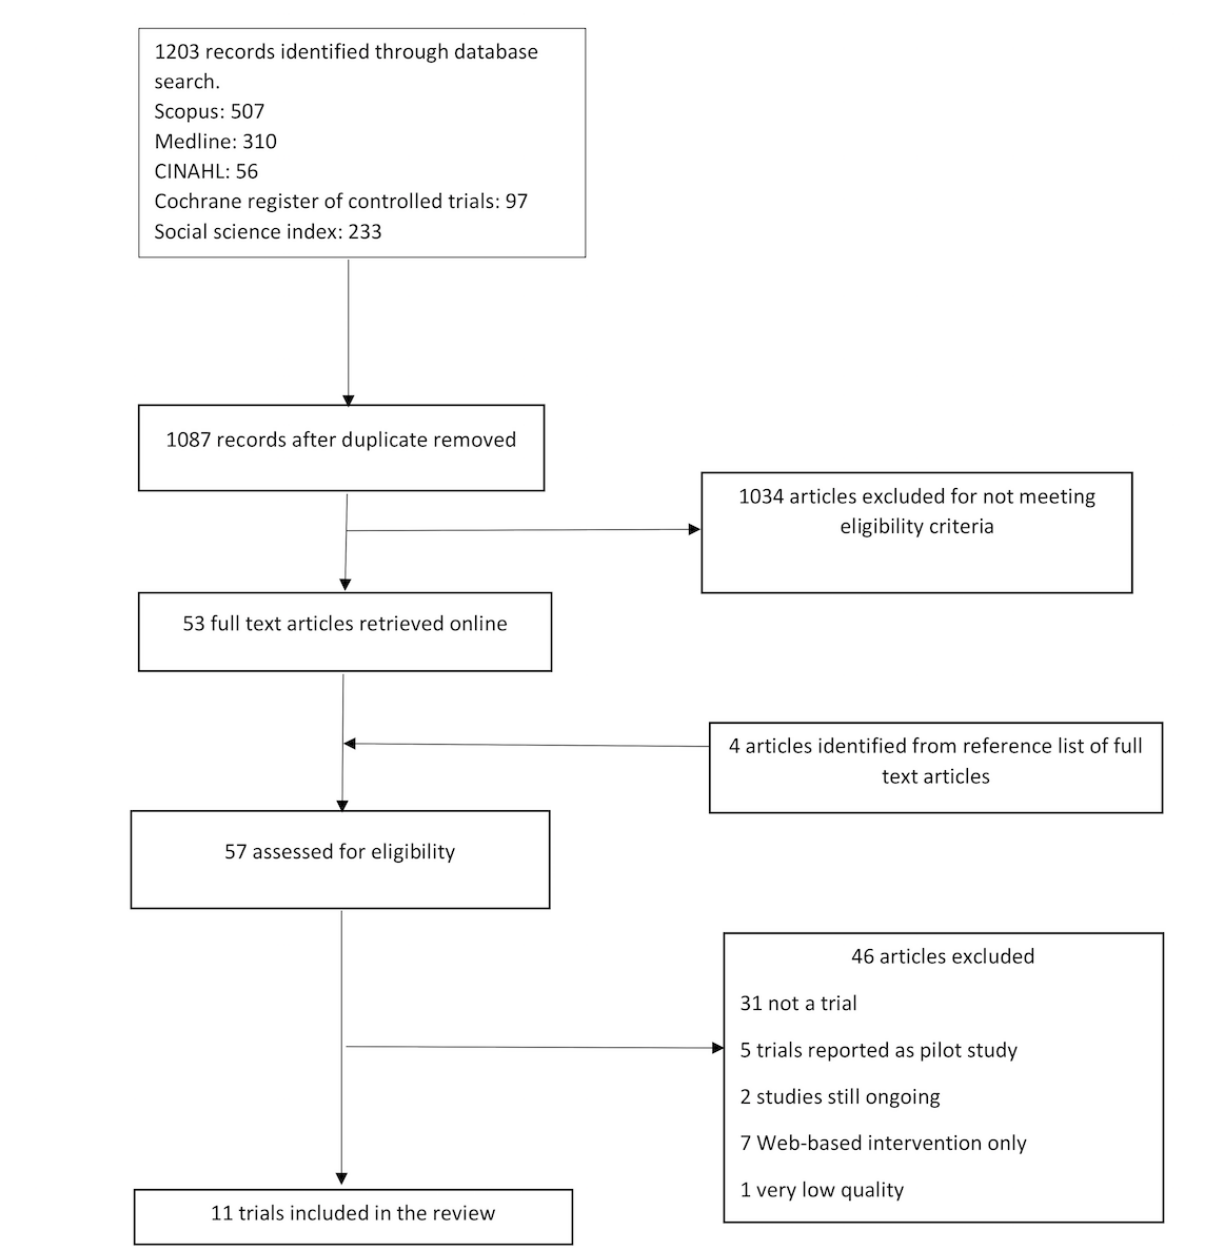
Figure 1. Flow diagram of the study selection